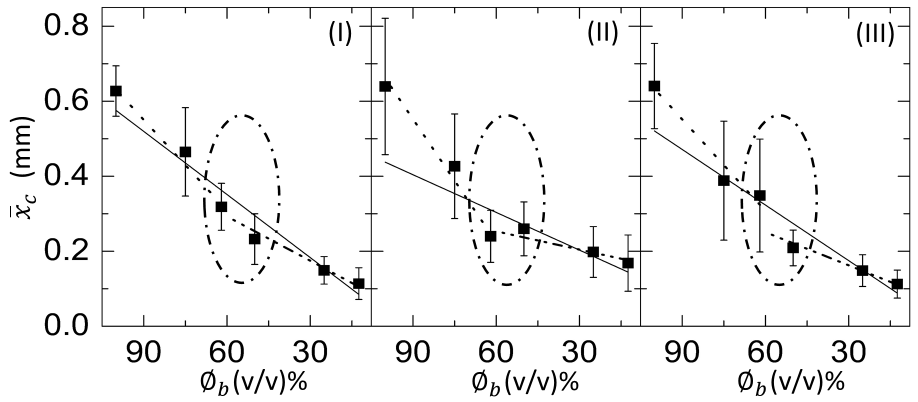
Figure 12. Concentration dependence of the averaged crack spacing ( x c ) of the whole human blood film at different substrate temperatures (T) at ( I ) 45 ◦ C, ( II ) 35 ◦ C, and ( III ) 25 ◦ C. The solid green line depicts the linear fit done over the whole range from 100 to 12.5%. The dotted and dash-dotted lines show the linear fit from 100 to 62, and 62 to 12.5% ( v / v ). The oval line highlights a kink at 62% ( v / v